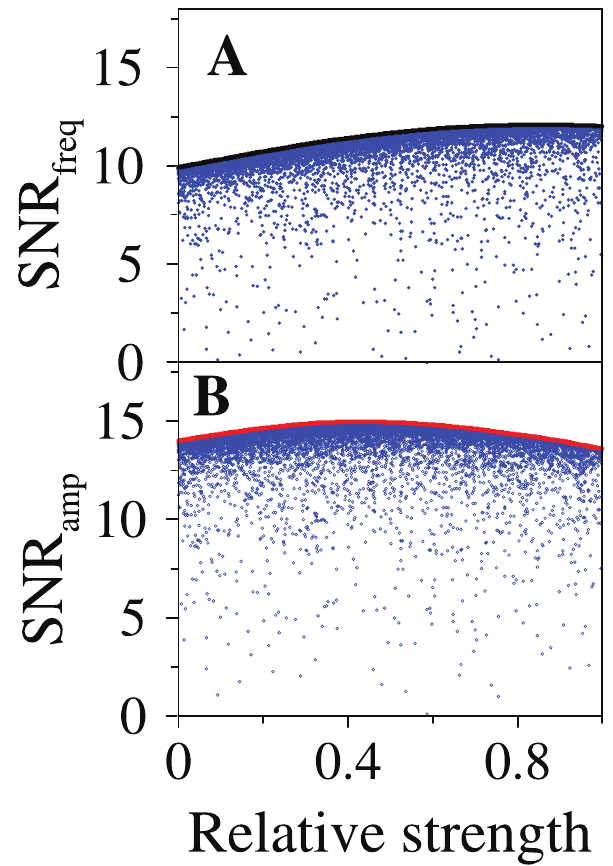
Figure 5. Noise tolerance is robust in coherent FFLs. A. Frequency SNR for the coherent FFL module. Black line: Maximum SNR. The scattered points correspond to an ensemble of * 15,000 different circuits generated by randomly sampling susceptibility values within the interval ½ 0, 5 (cid:2) . B. Amplitude SNR for coherent FFL. Red line: Maximum SNR. The scattered points correspond to the same ensemble of panel A.